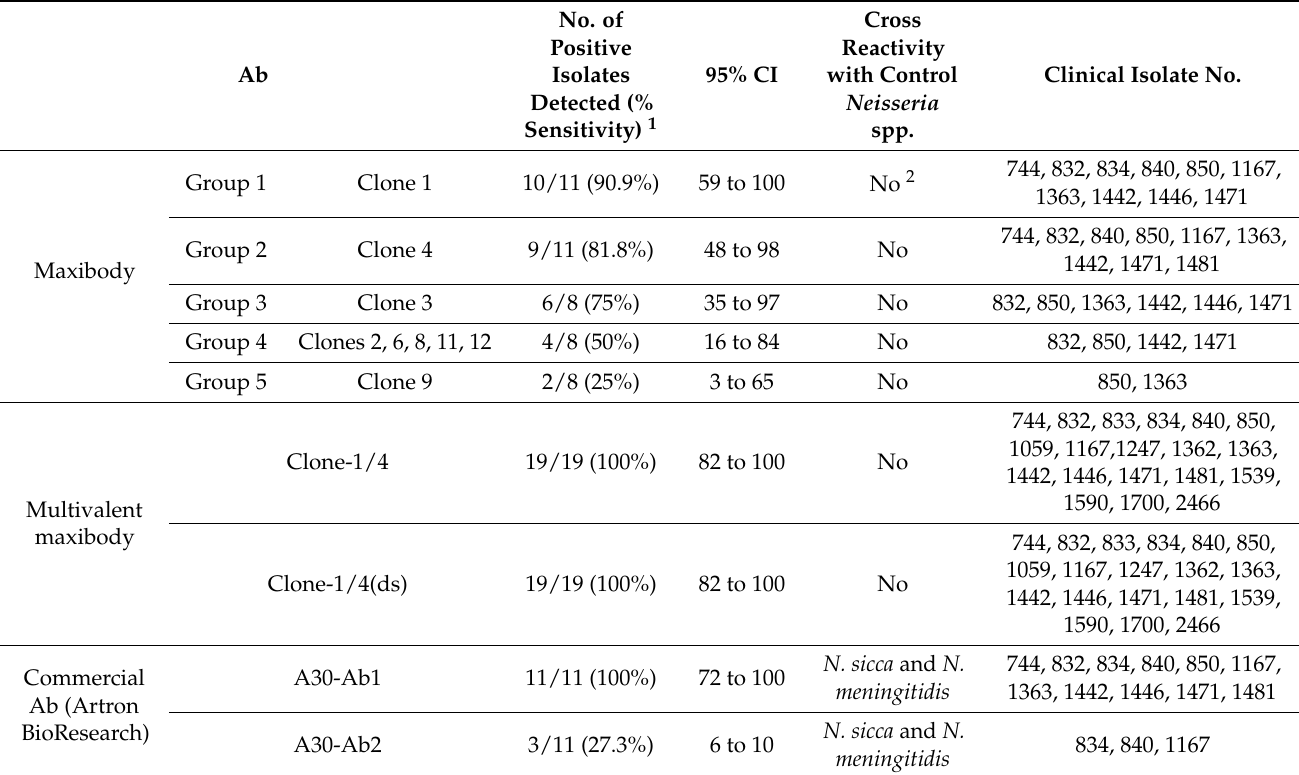
Table 3. Characterization of maxibodies according to Ab specificity for clinical